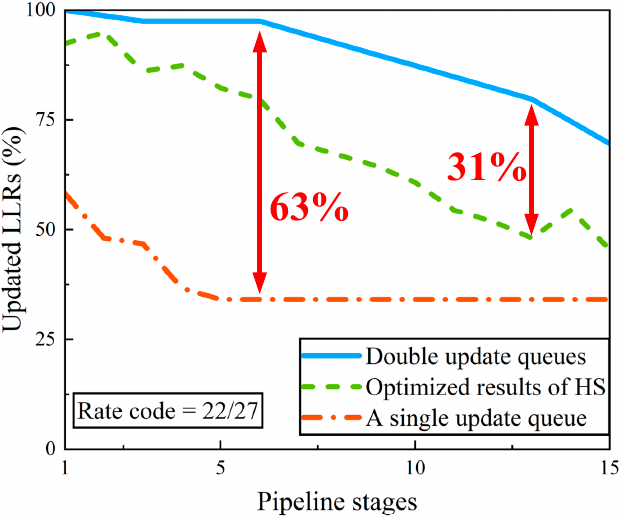
Figure 5. Percentage of updated LLRs per iteration during decoding as a function of number of pipeline stages for rate 22/27 from 5G NR. HS: Decoder with the hybrid schedule.